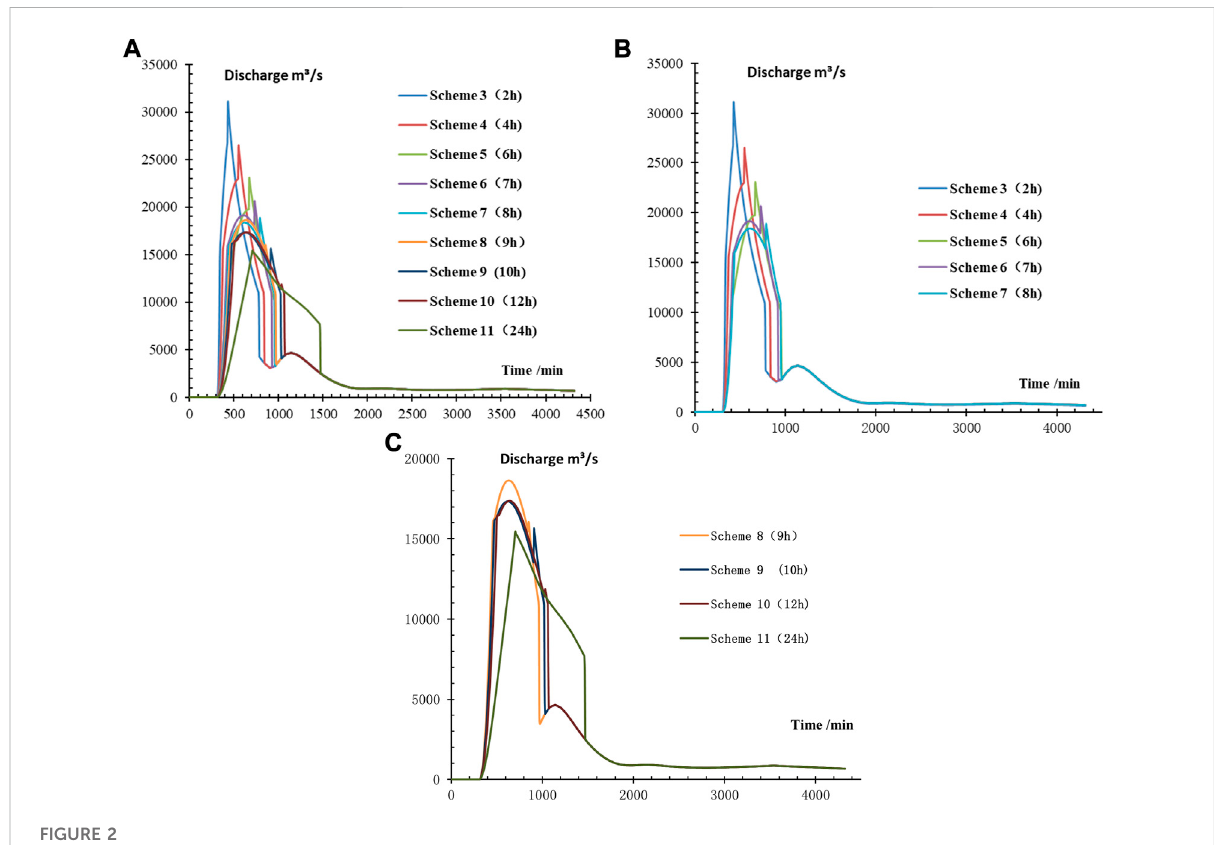
FIGURE 2 Discharge hydrograph of the dam